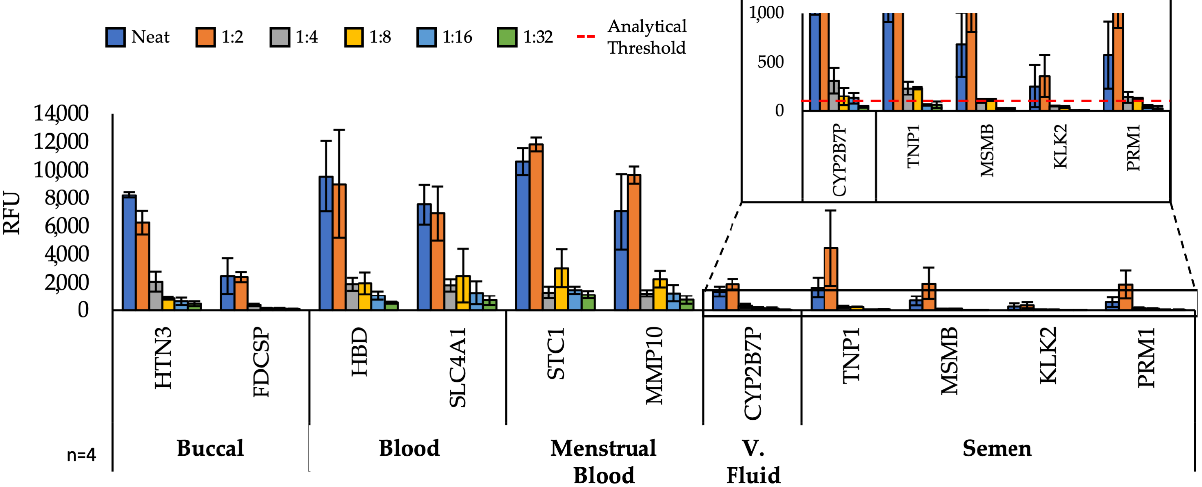
Figure 6. Separation of all single-source body fluids to determine the sensitivity of on-disc fluorescent detection. Amplified neat samples were serially diluted down to a 1:32 dilution to examine the sensitivity of the microfluidic platform. The inset shows a closeup of the Pentaplex panel of targets and the analytical threshold (100 RFU) of the μ Edisc.